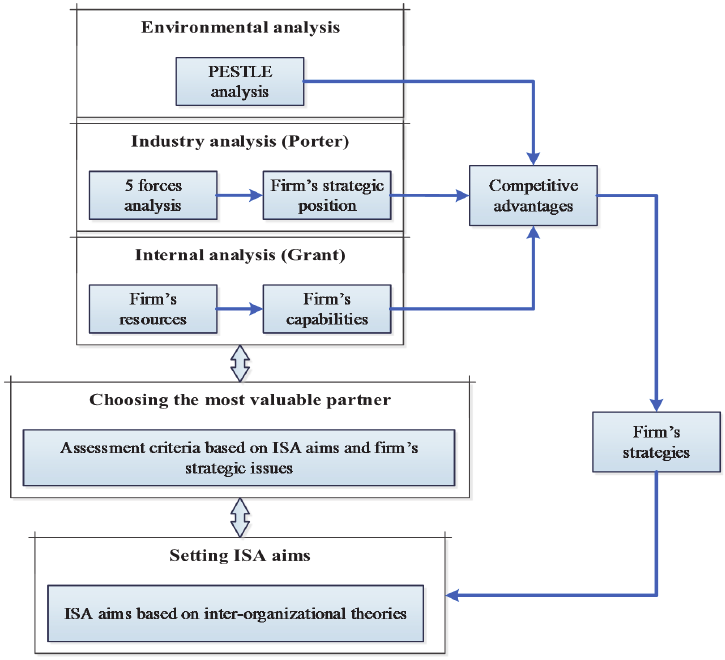
Fig. 1. An overview of the